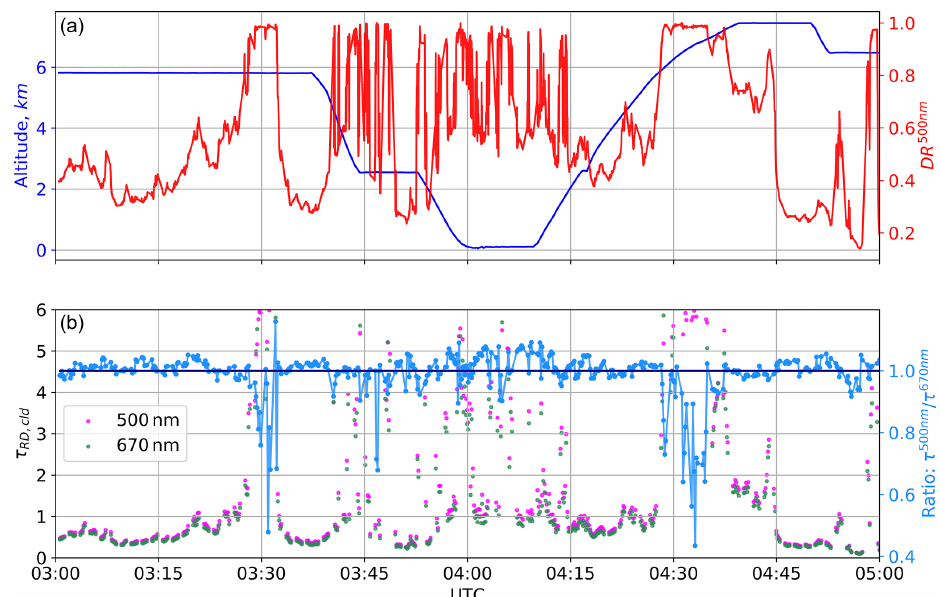
Figure 11. Time series of 6 September 2019, partial flight track of (a) P-3 Altitude and DR 500nm mea , (b) τ 500nm τ 500nm /τ 670nm is also RD,cld RD,cld